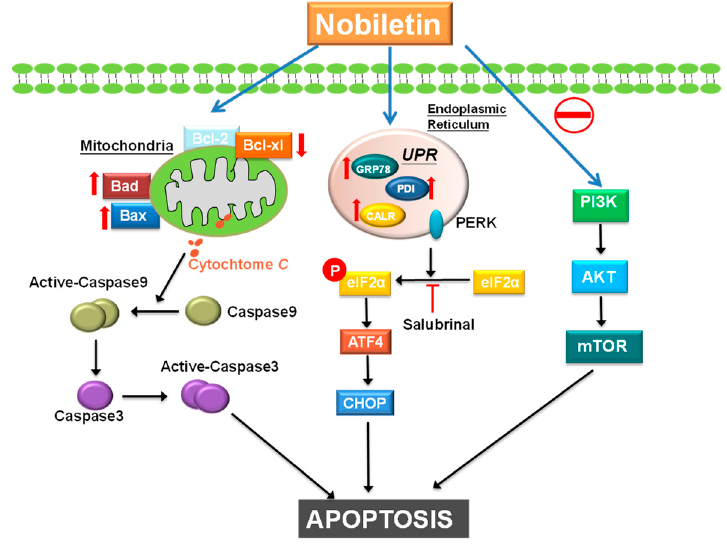
Figure 6. Nobiletin-induced apoptotic pathway in bladder cancer cells. The anti-cancer effect of nobiletin is mediated by the induction of mitochondria dysfunction and ER stress signaling pathways also involves downregulation of the PI3K/AKT/mTOR pathway.